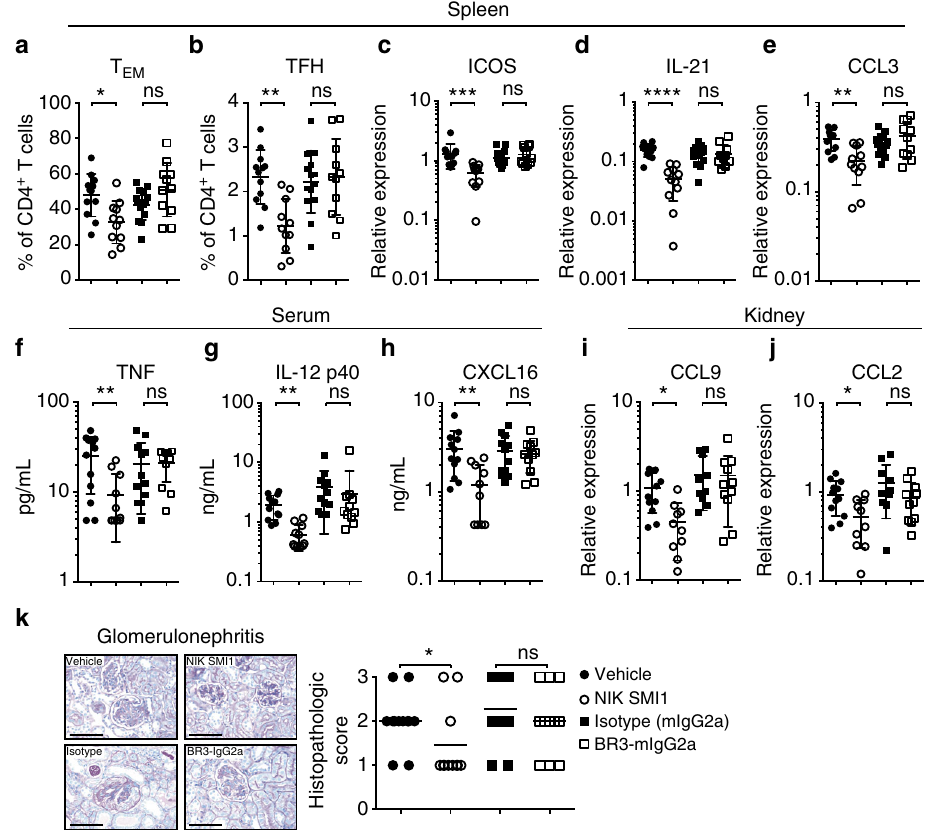
Fig. 6 NIK inhibition suppresses BAFF-independent biology in NZB/W F1 mice. a , b Percentage of T effector memory (T EM , CD4 + CD44 + CD62L − ) ( a ) and T follicular helper cells (T FH , CD4 + CXCR5 + PD1 + ) ( b ) of CD4 + T cells. c – e Splenic gene expression of ICOS ( c ), IL-21 ( d ) and CCL3 ( e ), as determined by Fluidigm. f – h Serum levels of TNF (Luminex) ( f ), IL-12p40 (ELISA) ( g ), and CXCL16 (ELISA) ( h ). i , j Kidney gene expression, as determined by Fluidigm,